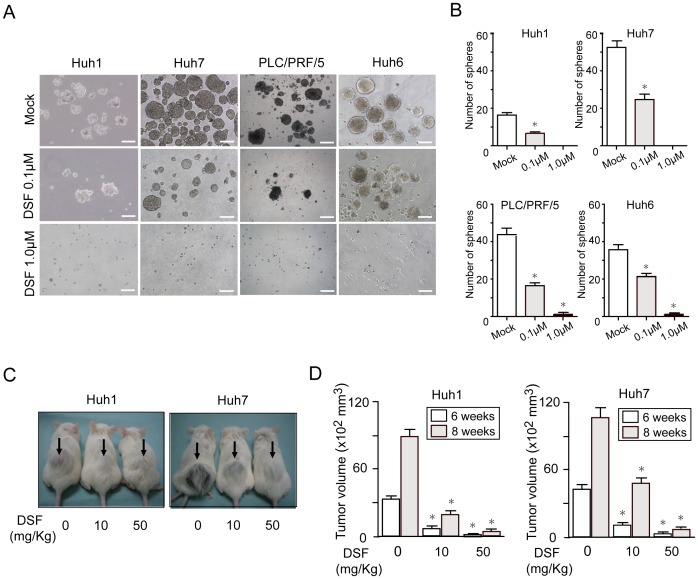
Sphere formation assays on HCC cells and xenograft transplantation.(A) Non-adherent sphere formation assay on HCC cell lines at day 14 of culture. Bright-field images are shown. Scale bar = 200 μm. (B) Number of large spheres generated from 1,000 HCC cells treated with DSF. *Statistically significant (p<0.05). (C) A total of 2×106 Huh1 or Huh7 cells were transplanted into the subcutaneous space of NOD/SCID mice. The growth of subcutaneous tumors (arrows) was apparently suppressed by the DSF treatment in a dose-dependent manner 8 weeks after transplantation. (D) Subcutaneous tumor volume was determined 6 and 8 weeks after transplantation. *Statistically significant (p<0.05).